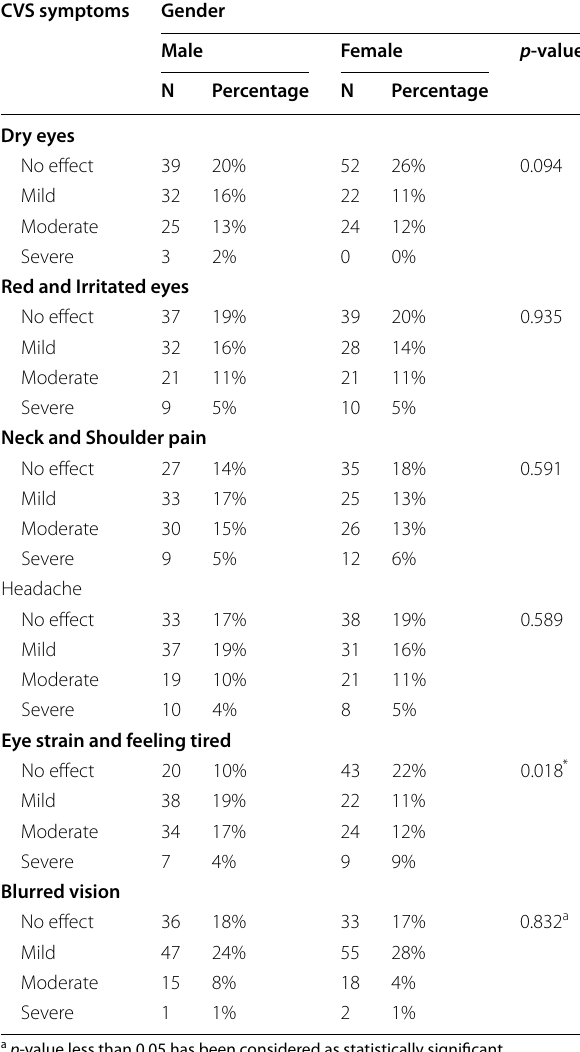
Table 3 CVS symptoms and the correlation with the